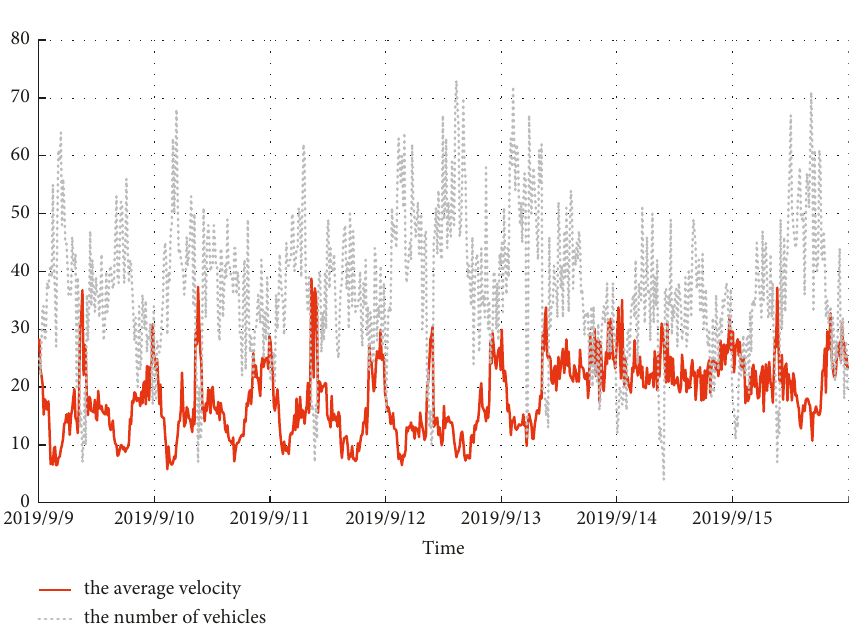
Figure 7: The variation trend of each attribute information in grid (1,